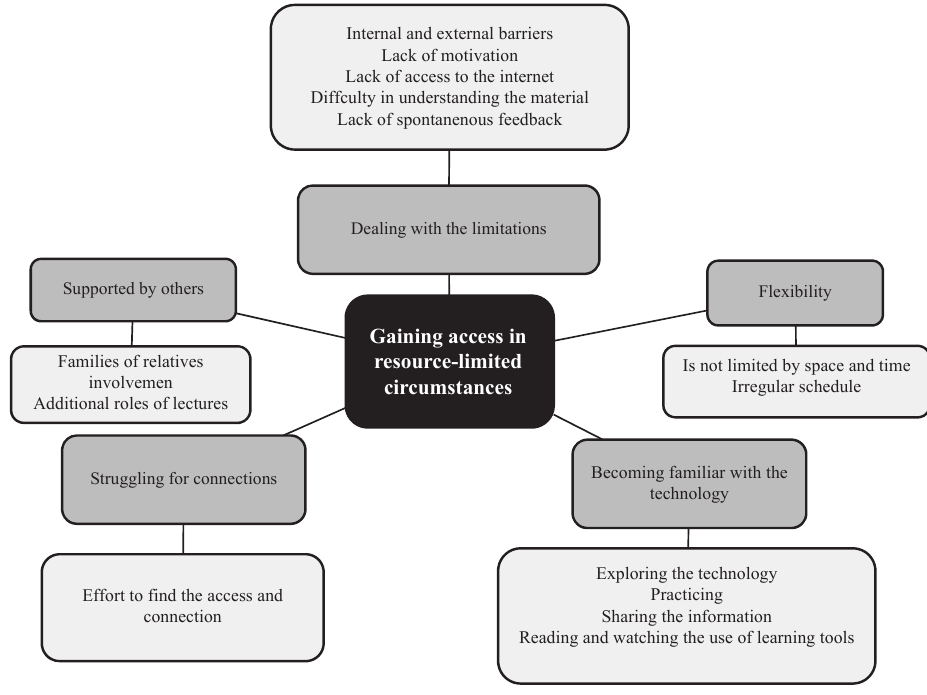
Figure 1. A concept map of nursing students’ experiences of online learning during COVID-19